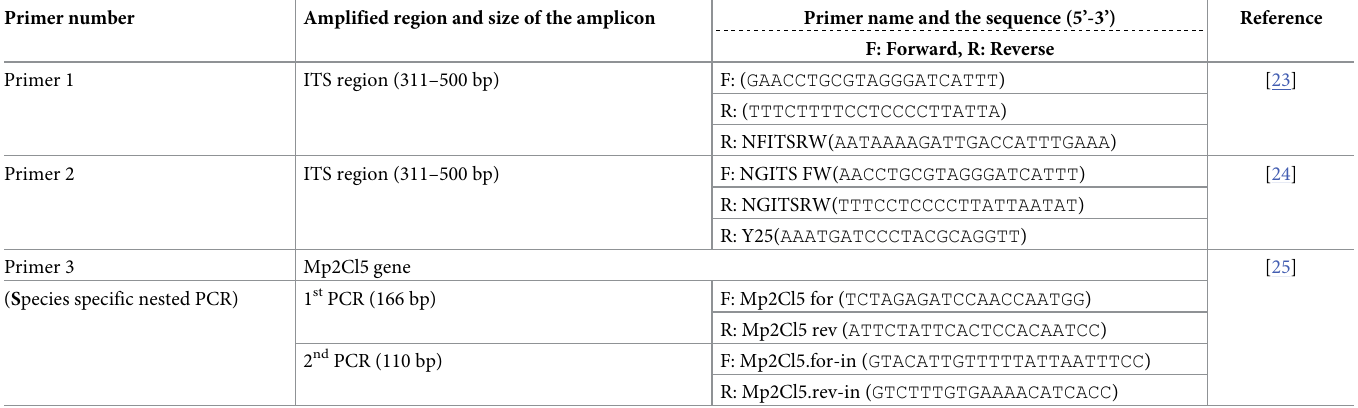
Table 1. Amplified regions and the primers used in the